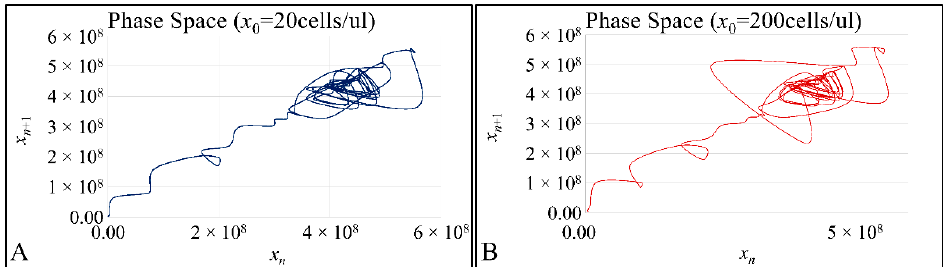
Figure 9 . The phase-space for x 0 = 20 cells/ μ L ( A ) and x 0 = 200 cells/ μ L ( B ). Figure 9. The phase-space for x